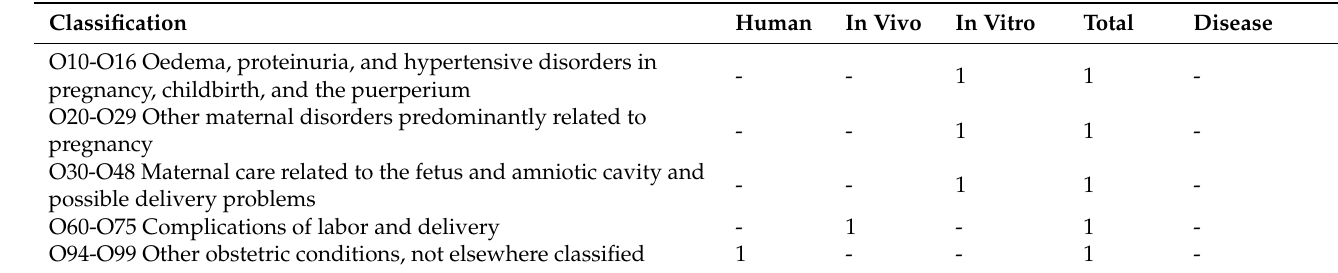
Table 18. The statistics of pharmacological results and its major diseases of SMC by experimental type in XV Pregnancy, childbirth, and the puerperium of